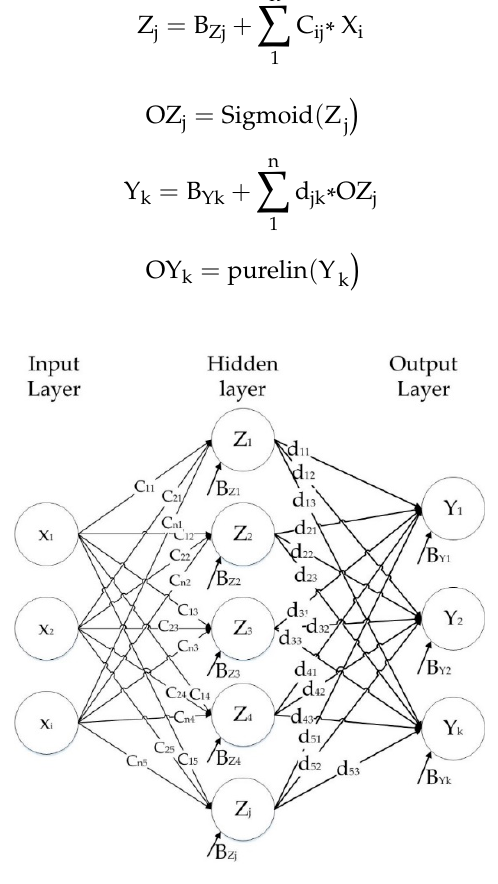
Figure 11. ANN architecture for system recognition.